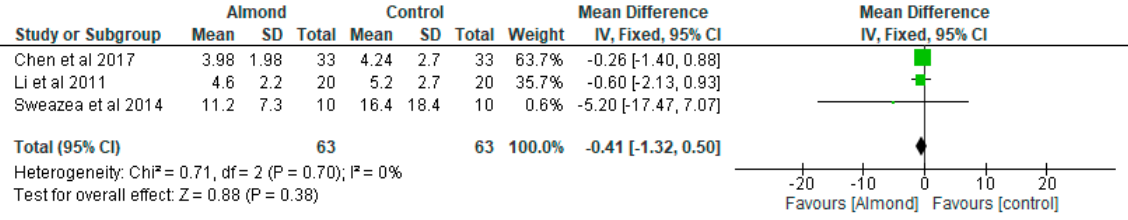
Figure 6. The effect of almond on HOMAR–IR.